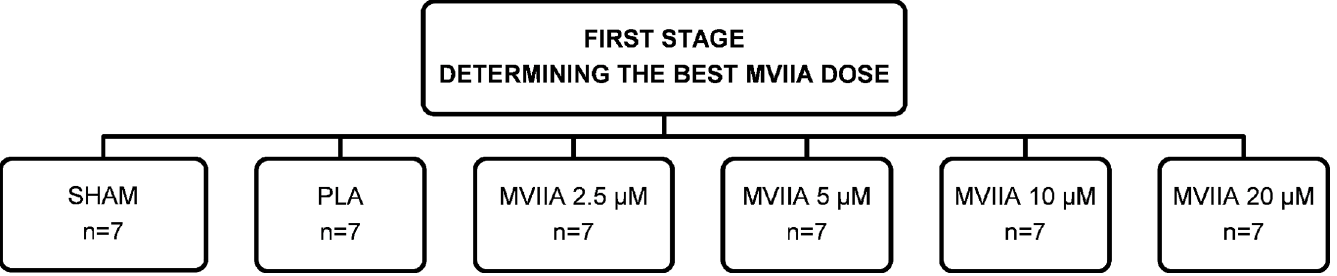
Fig 1. Flow chart of the study design to determine the best omega-conotoxin MVIIA dose in spinal cord injury. SHAM rats and rats subjected to SCI and injected with placebo (sterile PBS/vehicle, control, designated PLA rats) or MVIIA (designated MVIIA 2.5 μM rats, MVIIA 5 μM rats, MVIIA 10 μM rats, and MVIIA 20 μM